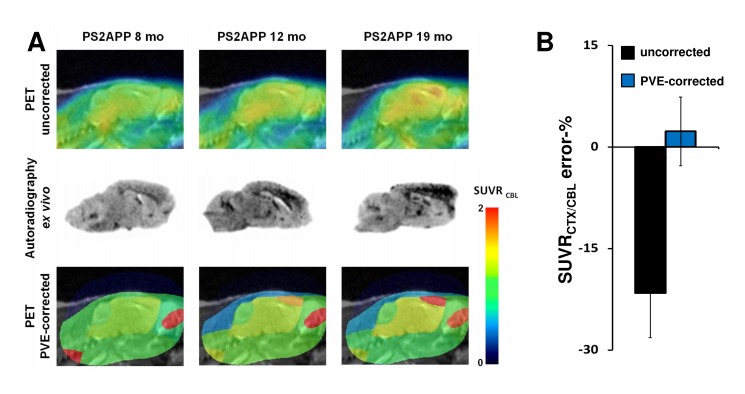
Amyloid-PET and ex vivo autoradiography in PS2APP mice before and after PVEC.
(A) Comparison of uncorrected [18F]-florbetaben PET images (upper row), corresponding ex vivo autoradiography (mid row) and PVE-corrected PET (lower row) of representative PS2APP mice at 8, 12 and 19 months of age. Sagittal PET images captured 1.6 mm left of the midline were scaled to cerebellum and overlain on a 3T MRI mouse template [13]. PVEC was performed with a 10 region mask (four cerebral and six extracerebral VOIs). (B) Error-(%) (±SD) of uncorrected (black bar) and PVE-corrected (blue bar) data versus ex vivo autoradiography are shown for the whole group of PS2APP mice.